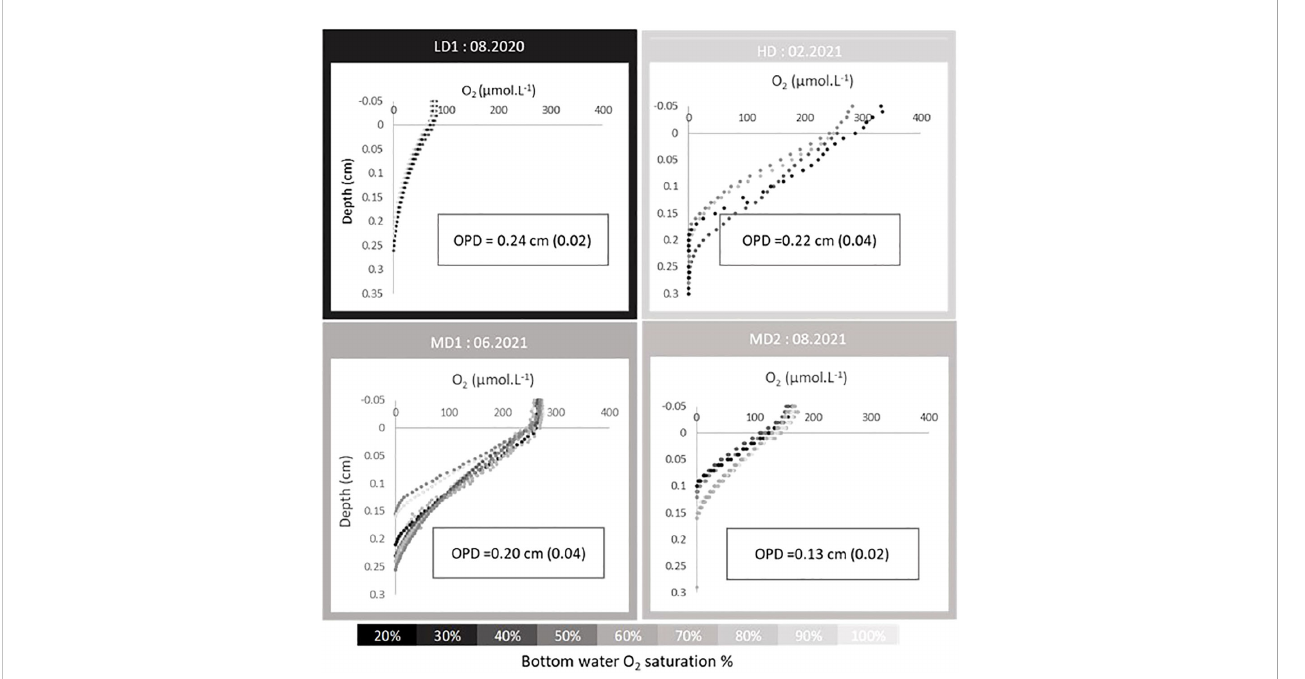
FIGURE 5 Oxygen pro fi les through sediment – water interface and respective oxygen penetration depth (mean and standard deviation) for the different campaigns at Le Pellerin. In situ temperature and oxygen saturation were maintained during pro fi ling except for the MD1 campaign where overlying water was accidentally